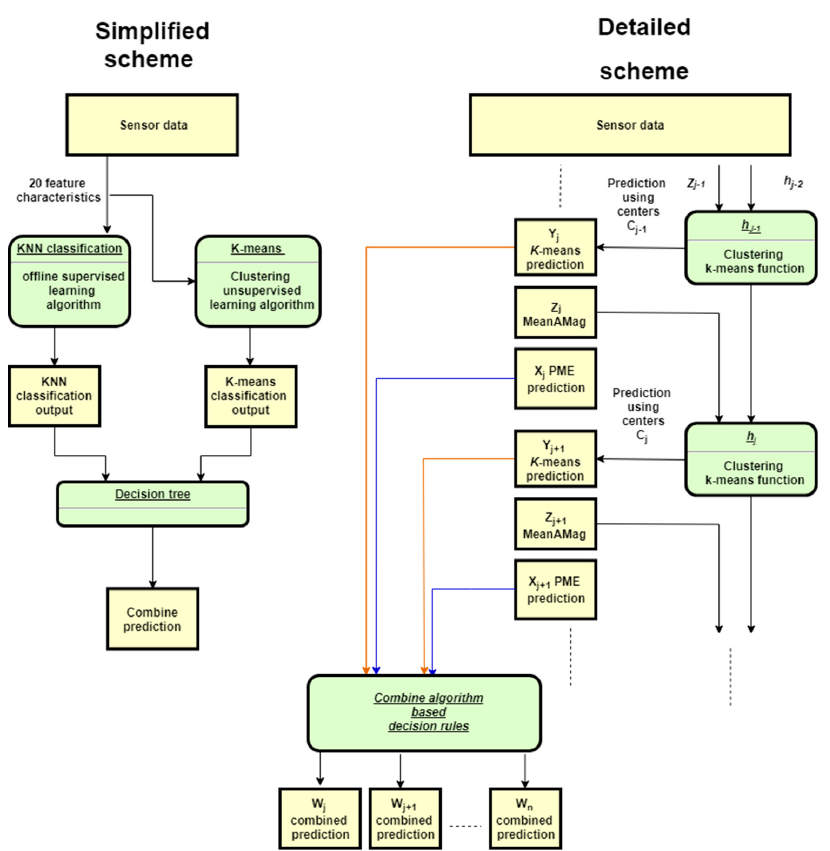
Figure 4. Combined offline and online learning scheme. In this scheme KNN refers to the K-nearest neighbours model (trained offline).